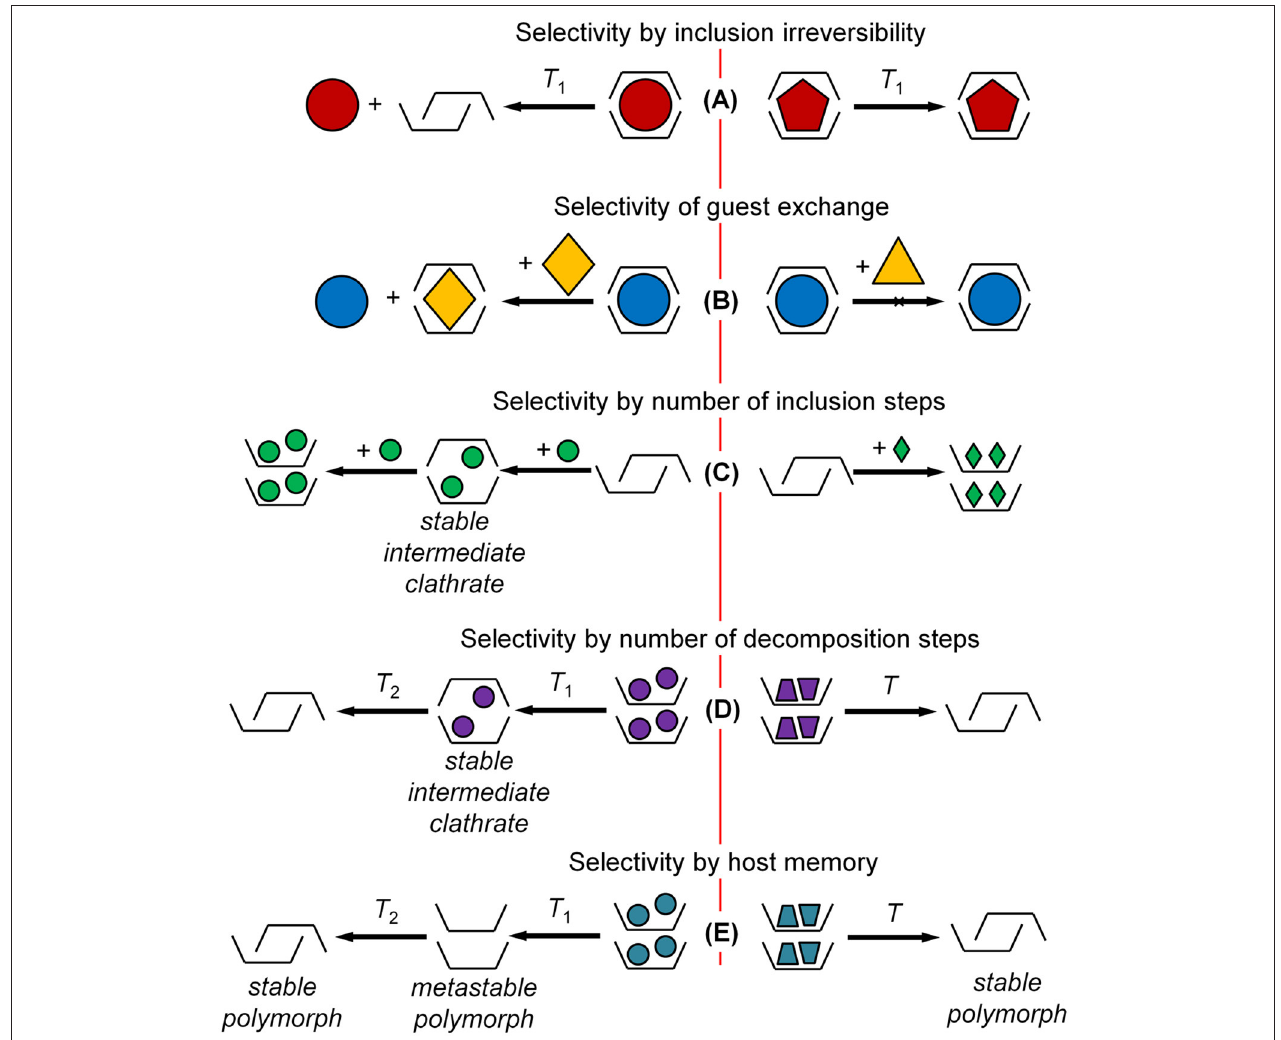
FIGURE 2 | Specific types of molecular recognition using solid-solid phase transitions. (A) Selectivity by inclusion irreversibility; (B) selectivity of guest exchange; (C) selectivity by number of inclusion steps; (D) selectivity by number of decomposition steps; (E) selectivity by host memory.